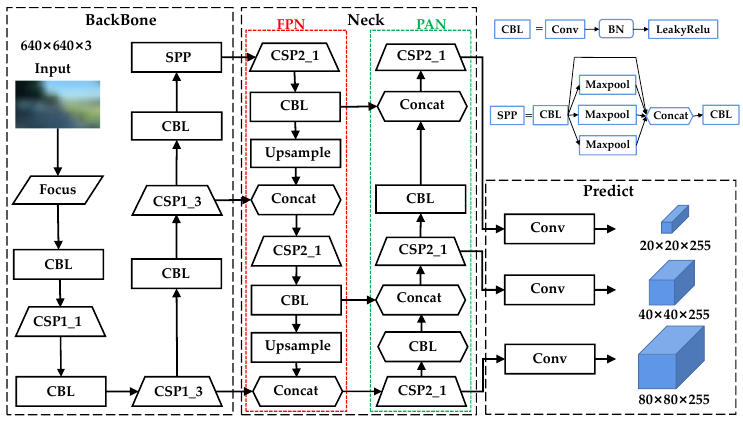
Figure 3. Network structure of YOLOv5s.